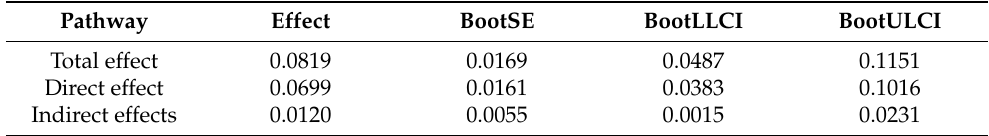
Table 4 . Table of total effect, direct effect and mediation effect.